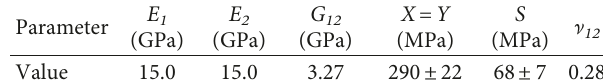
Table 5: Engineering constants of BFRP.